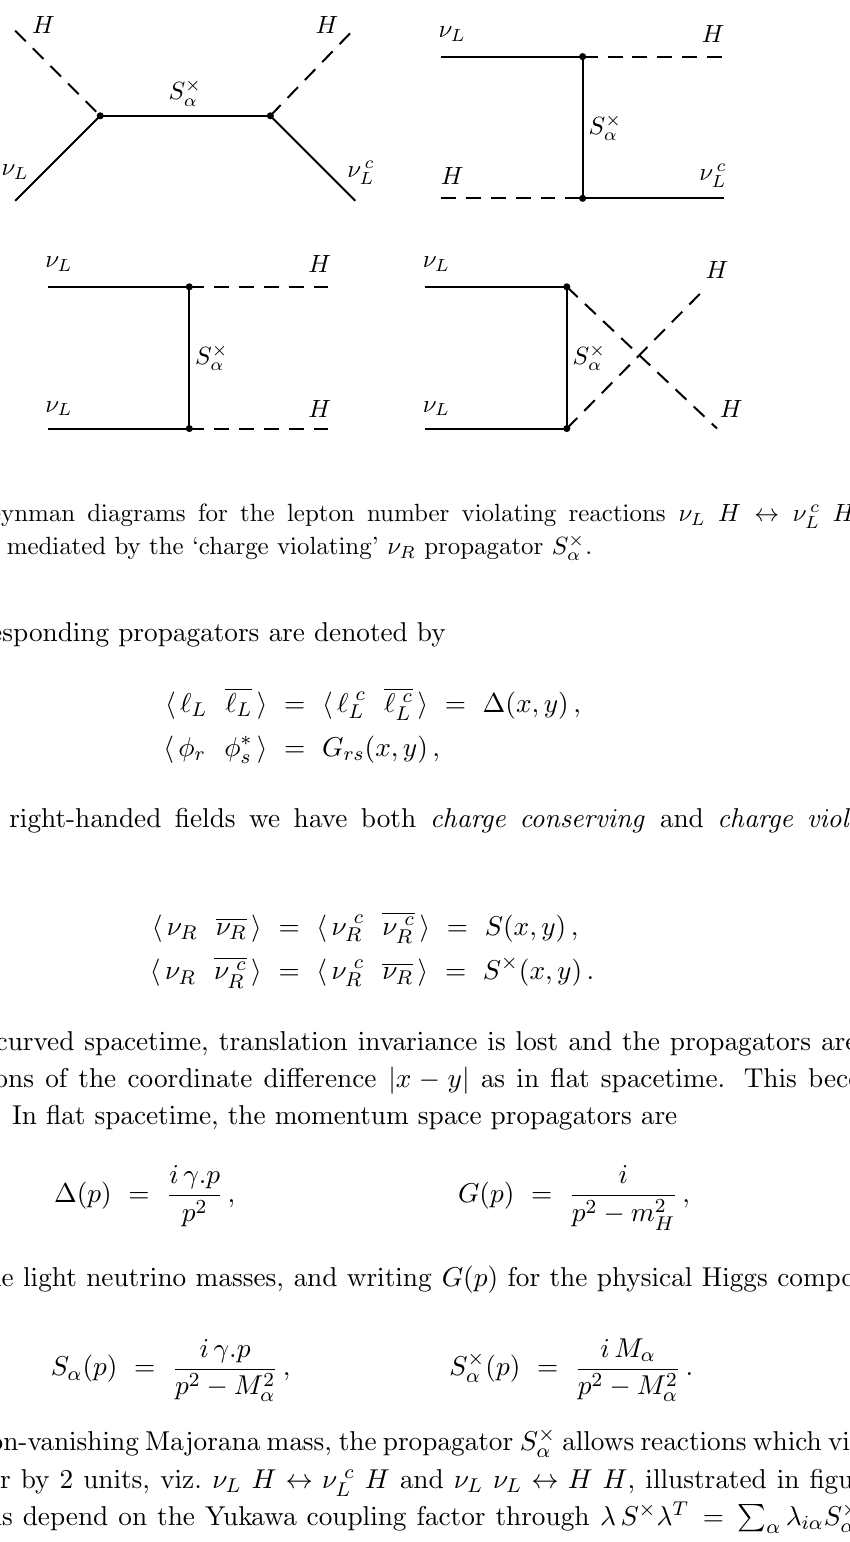
Figure 1 . Feynman diagrams for the lepton number violating reactions (cid:23) L H $ (cid:23) c (cid:23) L (cid:23) L $ H H , mediated by the ‘charge violating’ (cid:23) R propagator S (cid:2)